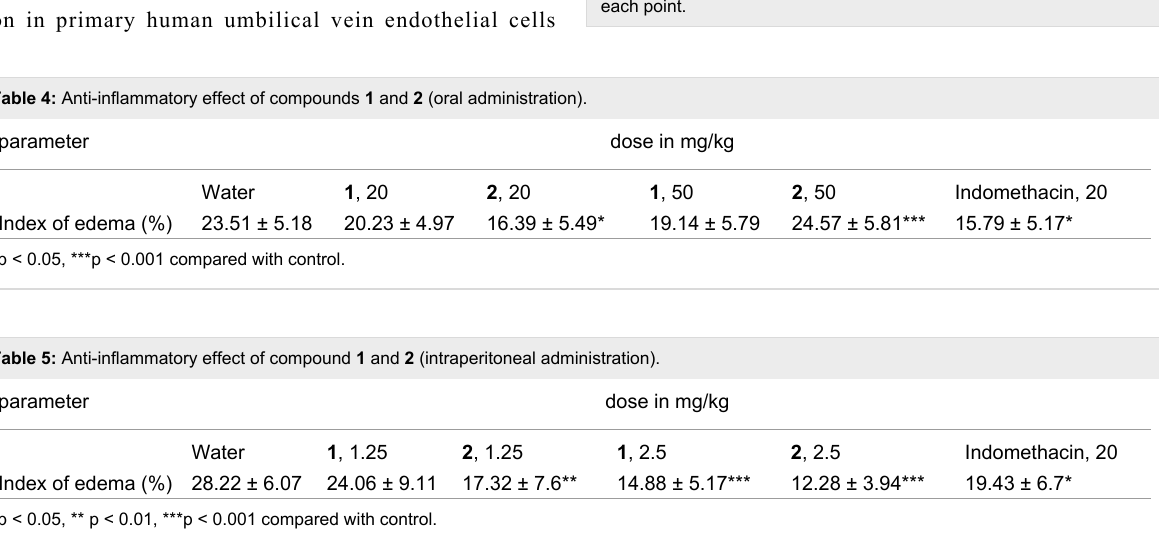
Figure 5: IL-6 production of primary endotheliocytes in the presence of compounds 1 and 2 . Error bars represent the standard deviation in each